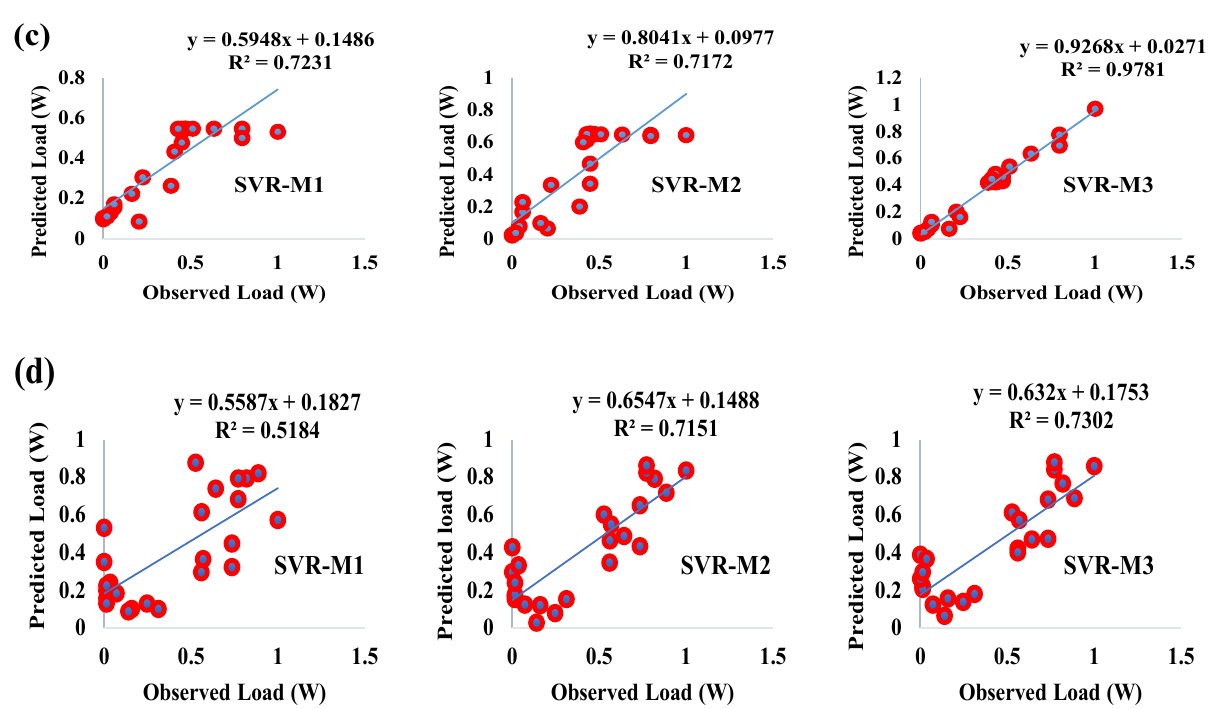
Figure 7. Scatter plot for ( a ) Kano, ( b ) Abuja, ( c ) Niger, and ( d ) Lagos. Further analysis can be conducted using a dimensional radar diagram for the predic- tion of load demand, which is depicted in Figure 8. It can be observed that SVR-M3 > SVR- M2 > SVR-M1 models were able to capture the best fitting pattern for Kano (R 2 > 0.9), Abuja, and Lagos (R 2 > 0.73), while SVR-M3 > SVR-M1 > SVR-M2 models were able to capture this for Niger (R 2 > 0.97). It is essential to note that the promising ability of SVR- M3 could be attributed to the fact that three variables were engaged in the prediction (temperature, wind, and solar radiation). That means this component includes all useful parameters that have an effective impact on load demand prediction. Similarly, the nu- merical comparison of multi-states with regard to MSE indicated that SVR-M3 (MSE = 0.0052) is superior to SVR-M1 (MSE = 0.0589), and SVR-M2 (MSE = 0.0384). The predictive error of the best model reduced by 2% on average for Kano. For Abuja, the simulated error of SVR-M3 reduced by 6% on average for both SVR-M1 and SVR-M2, and, lastly, the pre- dictive error of the best model decreased by 14% for Niger and 26% for Lagos.